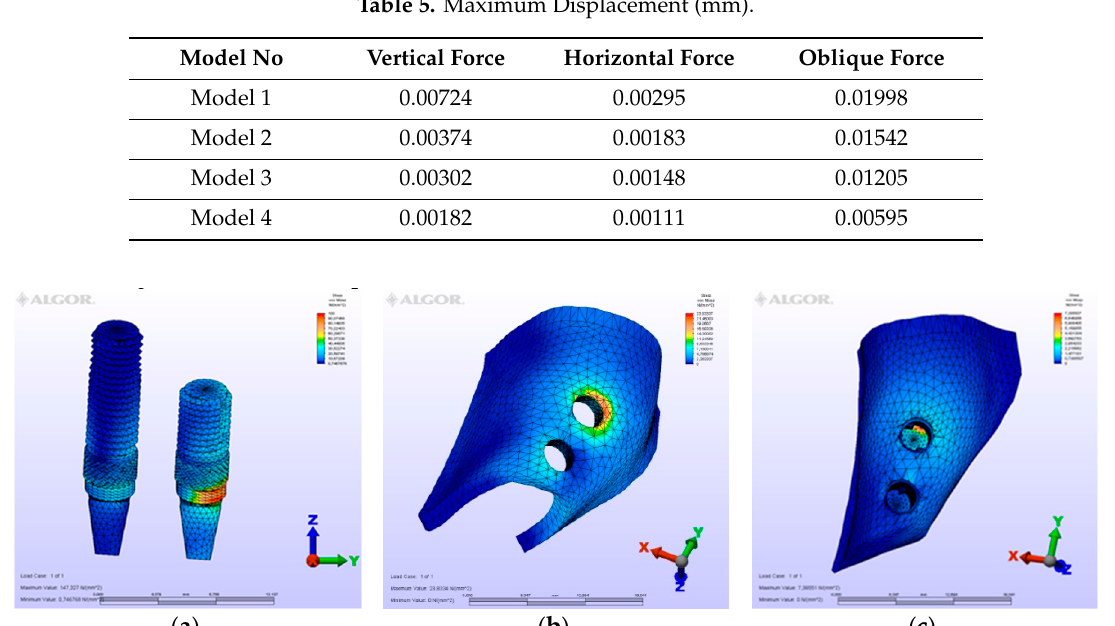
Table 5. Maximum Displacement (mm).